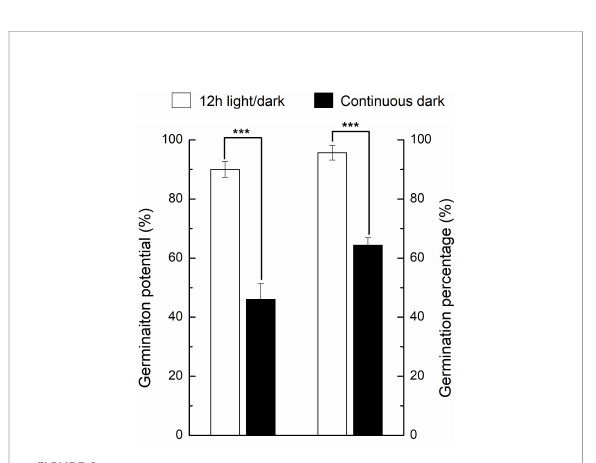
FIGURE 2 Germination percentage and germination potential of seeds under light and dark conditions. * indicates the signi fi cance of the test. * means signi fi cant at level 0.05; ** means signi fi cant at 0.01 level; *** means signi fi cant at 0.001 level. Same as